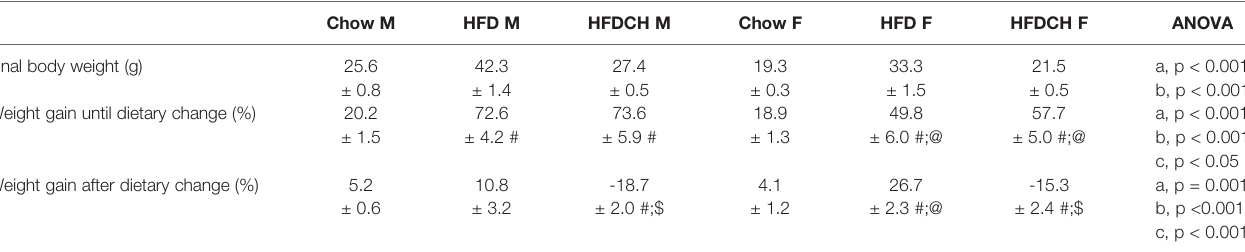
TABLE 3 | Final body weight, and weight gain in percentage of initial body weight up to and after the dietary change in male (M) and female (F) mice exposed to chow or a high-fat diet (HFD) for 12 weeks, or to a HFD for 8 weeks and then changed to chow for 4 weeks (HFDCH). Chow